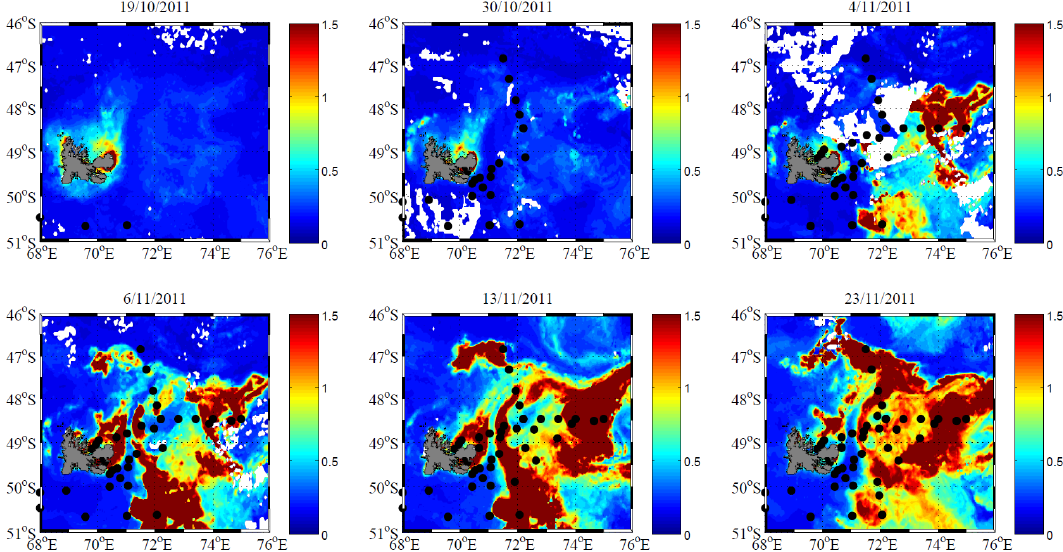
Figure 2. Satellite composite images of sea surface chlorophyll a (mgm − 3 ) at successive dates between the beginning of the KEOPS-2 cruise (19 October 2011) and the end of the cruise (23 November 2011). The locations of the water samples collected for radium analysis within the different time intervals are also reported (solid circles).